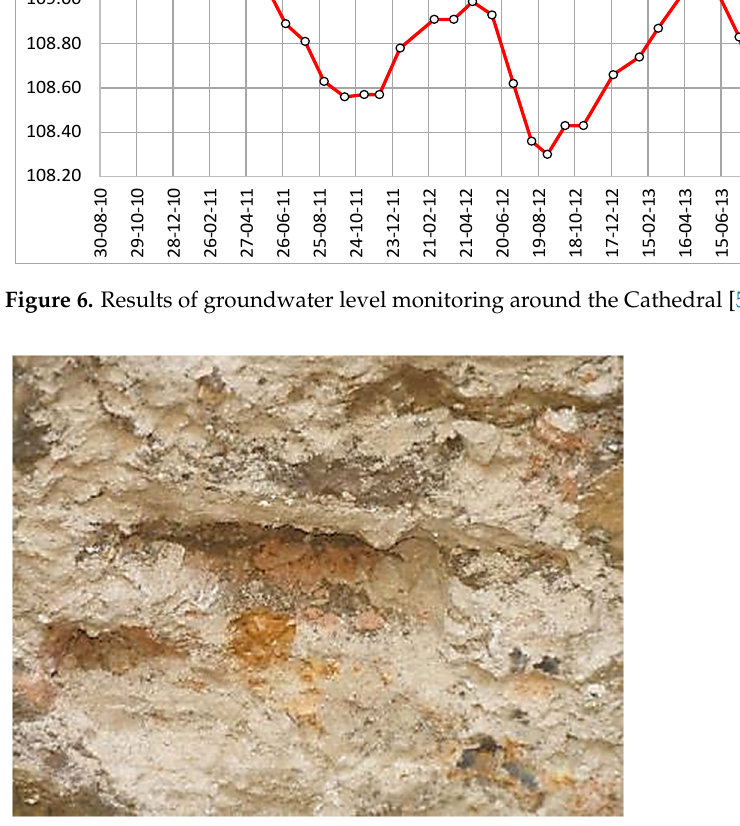
Figure 7. Appearance of the cleaned side surface of the lime concrete foundation.